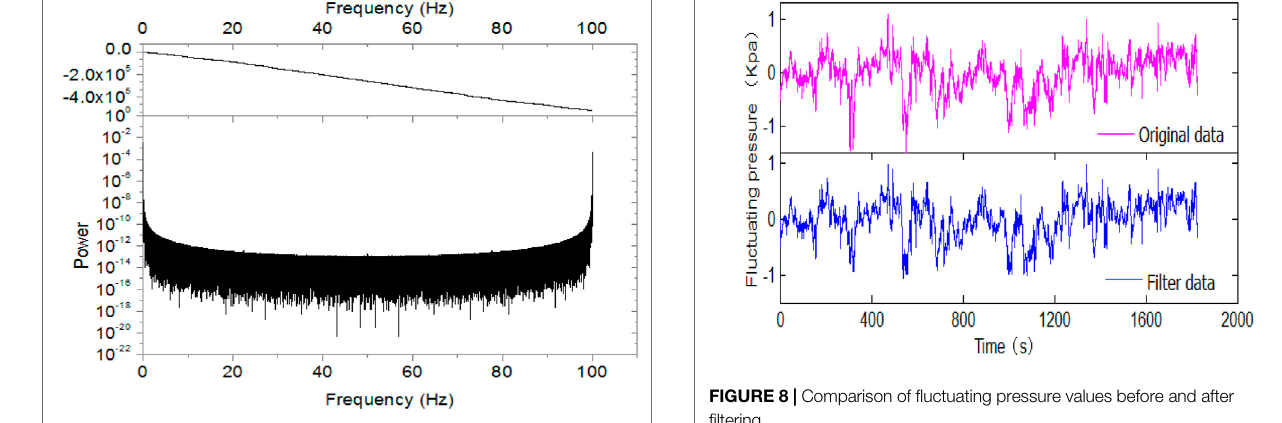
FIGURE 7 | Frequency spectra of a group of collected data after fast Fourier transform.